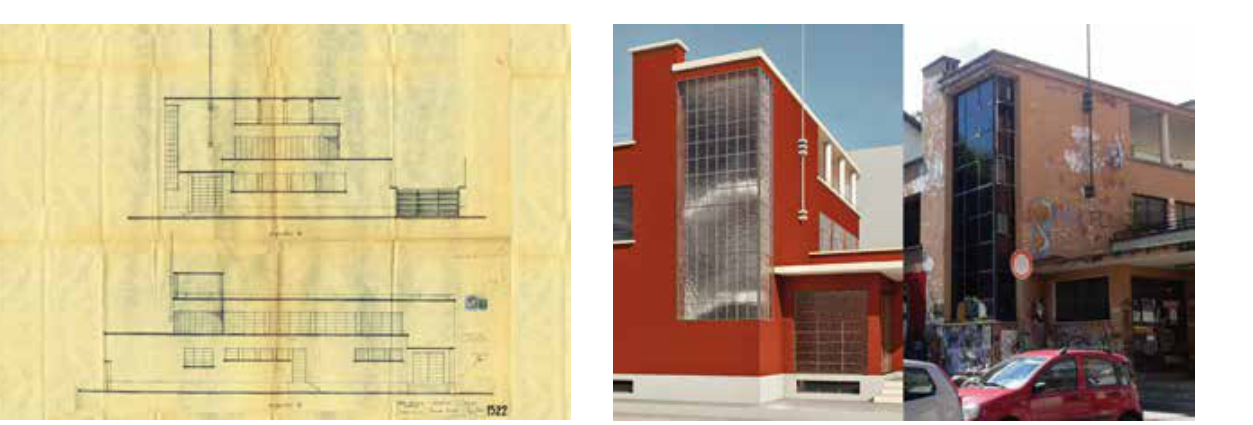
Figure 11. Archival drawing of the 'Casa rionale del Balilla di via Guastalla', by Costantino Costantini, 1933. Elevation. spaces. When 3D model becomes part of animated sequences, only some stop-images are rendered by soft realistic imagery.